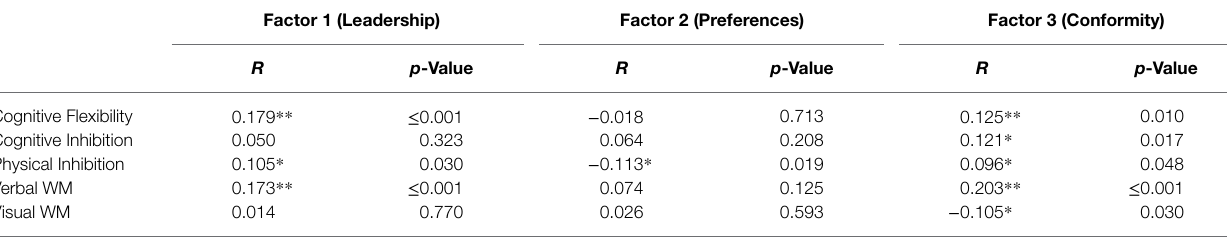
TABLE 4 | Correlations between executive function components and factors. Factor 1 (Leadership)